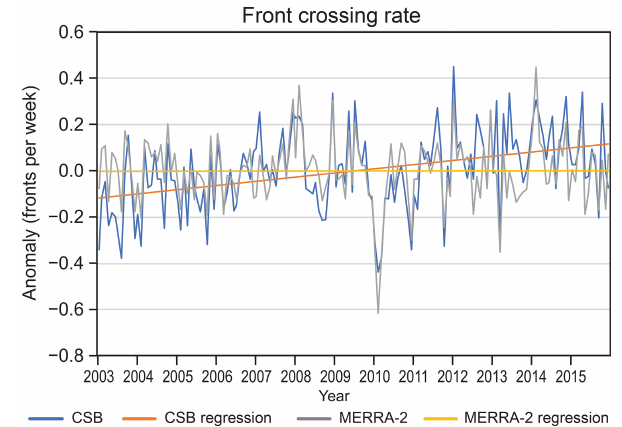
Figure 10. Monthly time series of the domain-average frontal crossing rate anomalies for CSB and for MERRA-2 analyzed by